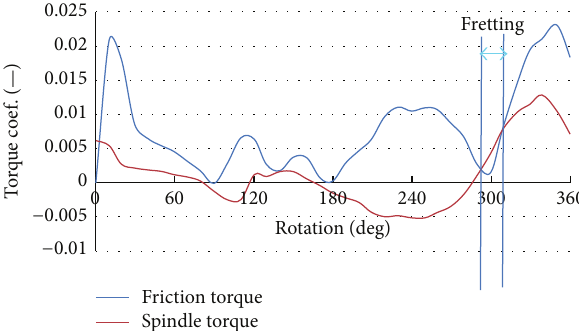
Figure 14: Fretting region of the propeller during one revolution in 𝑃/𝐷 = 0.8 .